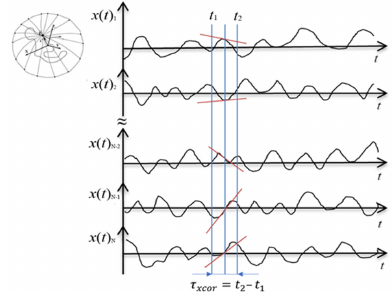
Figure 1. N realizations of a stationary random process with an autocorrelation interval τ x ≈ τ xcor . These implementations can be interpreted, for example, as changes over time t of the projection onto the X axis of the location of a particle randomly wandering in a closed region of 3-dimensional space.